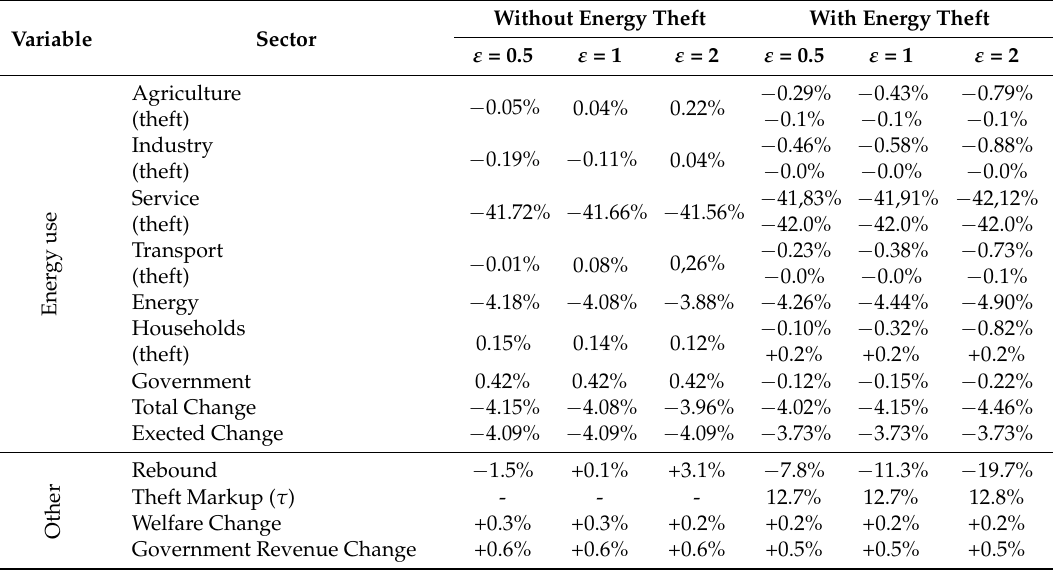
Table 4. Durables Efficiency, Sensitivity of Results to Elasticity of Substitution within Energy Nest.